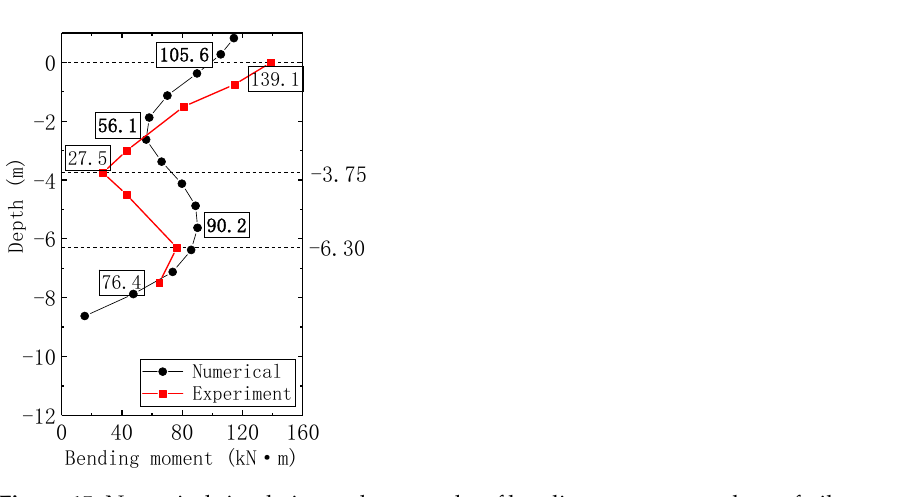
Figure 15. Numerical simulation and test results of bending moment envelope of pile.